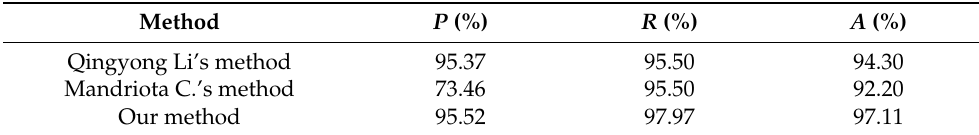
Table 5. Performance comparison between our method and the